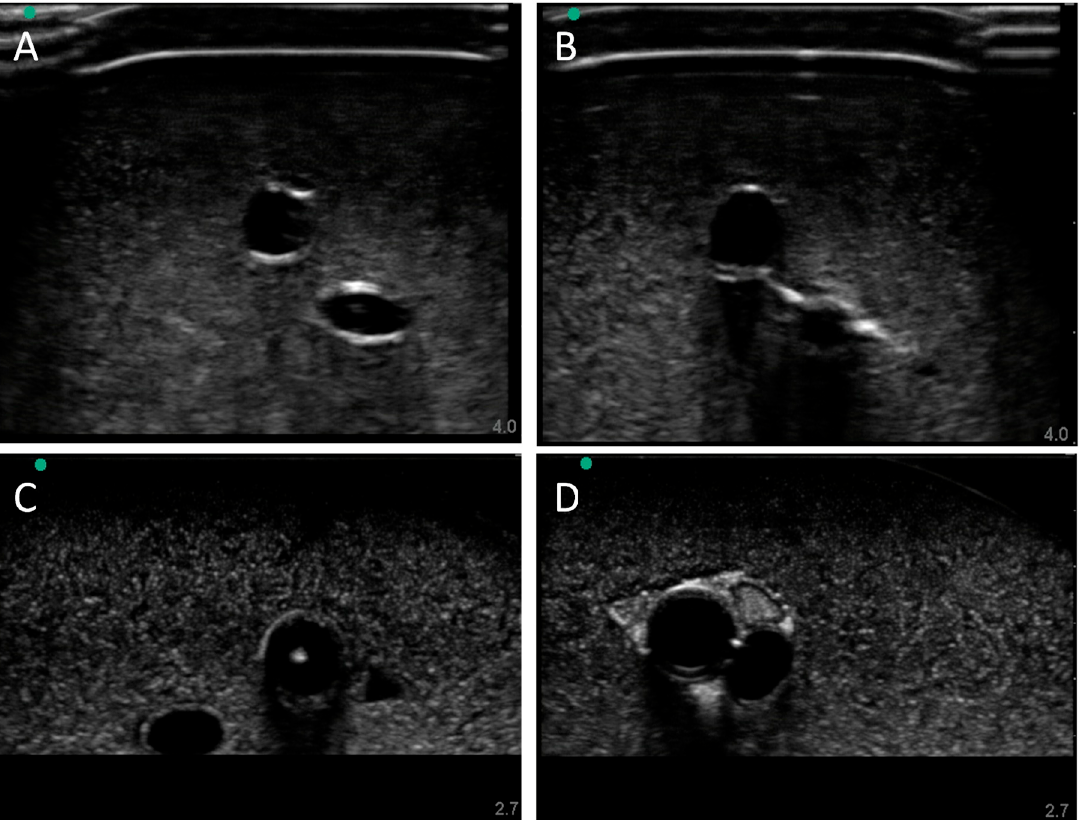
Figure 6. Human gelatin phantom ultrasound results. ( A ) Normovolemic conditions with a skin layer integrated in the model, showing both artery and vein for OOP ultrasound view. ( B ) Hypovolemic pressure conditions with a skin layer showing artery and vein for OOP ultrasound view. ( C ) Artery, vein, and nerve fiber bundle with distinct channels in the human phantom anatomy, no skin layer. OOP view is shown with a needle tip in view in the artery. ( D ) Human neurovascular bundle shown as OOP view.